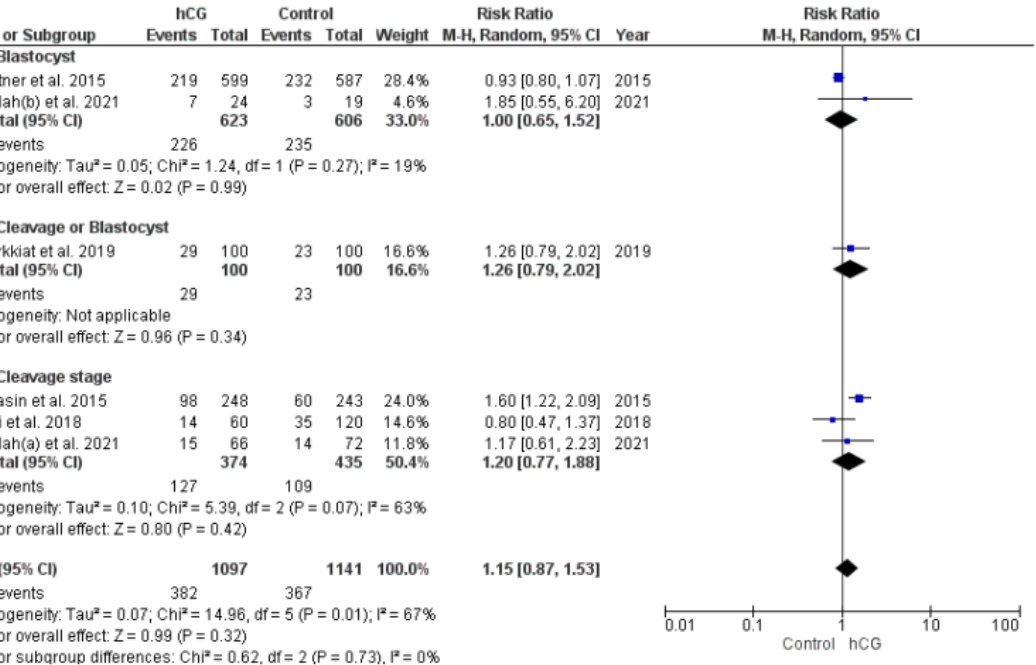
Ectopic pregnancy and stillbirths were reported in nine and three studies, respectively. The occurrence of these two adverse events was similar in the two groups (Figure 6).